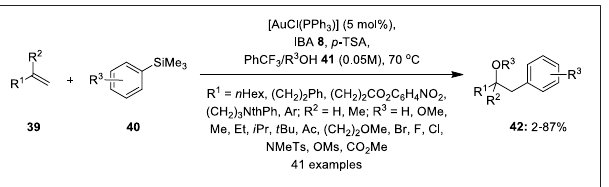
Frontiers in Chemistry |